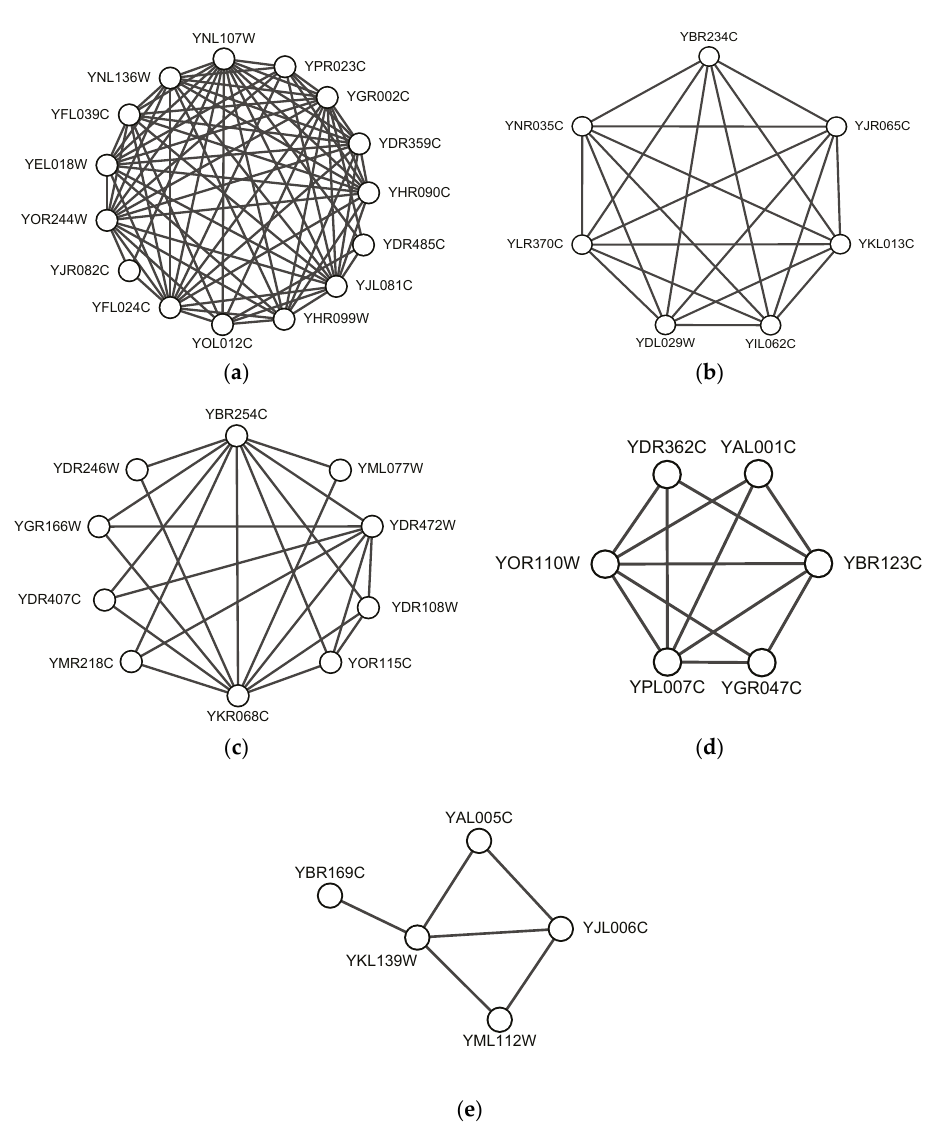
Figure 3. Examples of predicted complexes matching standard complexes: ( a ) NuA4 histone acetyltransferase complex predicted by SEGC on BioGrid; ( b ) Arp2/3 protein complex predicted by SEGC on Gavin02; ( c ) transport protein particle (TRAPP) complex predicted by SEGC on Gavin06; ( d ) transcription factor TFIIIC complex predicted by SEGC on Krogan_extend; ( e ) carboxy-terminal domain protein kinase complex predicted by SEGC on Gavin06.